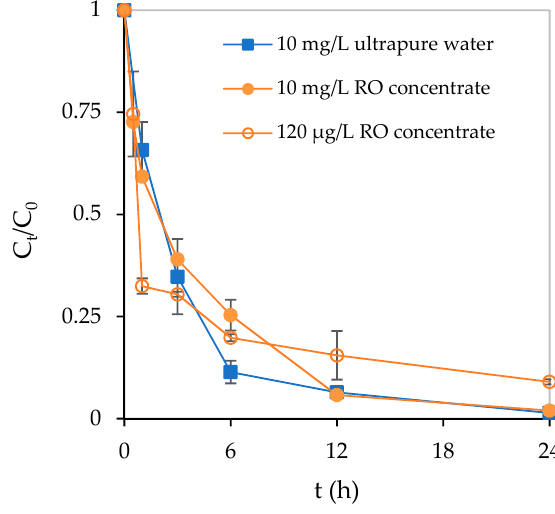
Figure 2. Adsorption of crotamiton using the HSZ-385/P25 composite sheet. Results are means ± standard deviations ( n = 2).